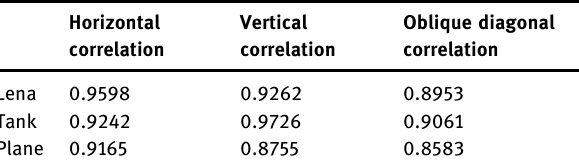
Table 1: Statistical experimental analysis table of image correlation before encryption